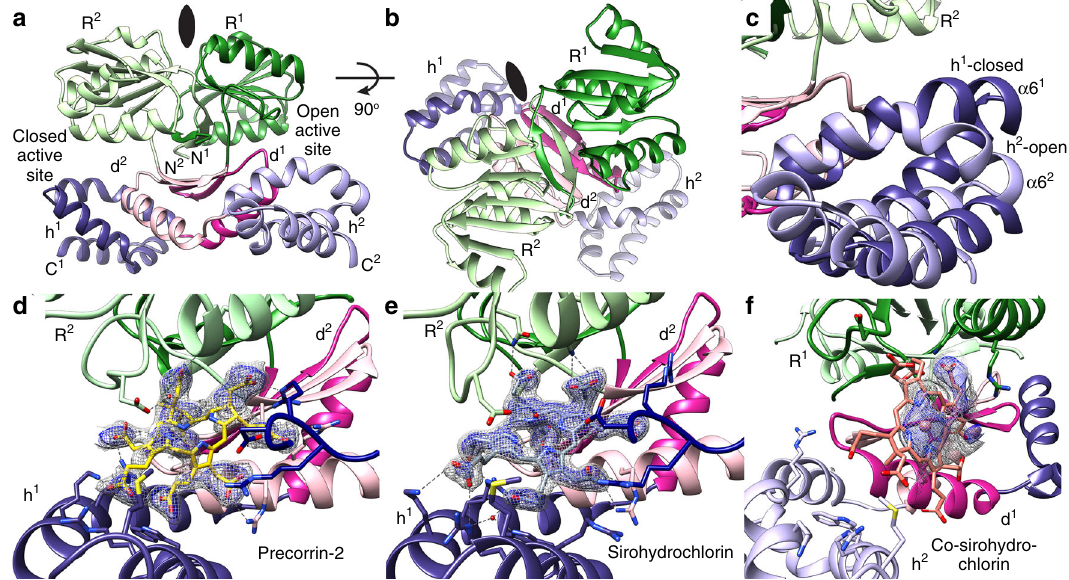
Fig. 2 CysG B architecture and tetrapyrrole binding. a CysG B is a homodimer with asymmetric cavities between the Rossmann fold (R) of one subunit and the helical domain (h) of the other, joined by a dimerization domain (d). The N- and C-termini are labeled for each and the SUMT is not shown for simplicity. The domains and subunits are colored as in 1b. b The Rossmann fold and helical domains are orthogonal to one another. c The helical domain has a different conformation in the two subunits, resulting in one cavity that is closed and another that is open. d Precorrin-2 binds in the closed active site with strong density for the carboxylates but weaker density for the core ring. The tetrapyrrole binds with an average B-factor of 53.0 Å 2 (compared with an overall B-factor for the structure of 50.9Å 2 and for local side chains of 51.9 Å 2 ) and occupancy at 0.5. e Sirohydrochlorin binds to the closed active site with strong density. The tetrapyrrole binds with an average B-factor of 40.0 Å 2 (compared with an overall B-factor for the structure of 51.3 Å 2 and for local side chains of 48.6 Å 2 ) and occupancy of 1.0. f Co-sirohydrochlorin binds to the open active site, nearly orthogonal to its conformation in the closed active site. The tetrapyrrole binds with an average B-factor of 77.3 Å 2 (compared with an overall B-factor for the structure of 77.2 Å 2 and for local side chains